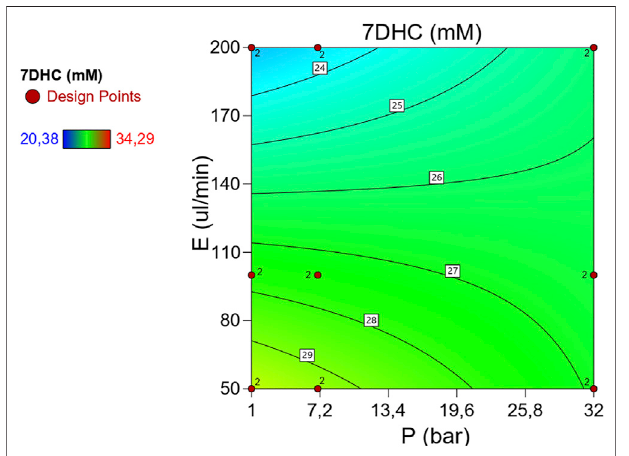
FIGURE 6 | Interaction plot of p , E effect in VD3 measurements using high-p,T autosampler. ( Average points in green. In blue and in red the lower and the upper leveraged values respectively